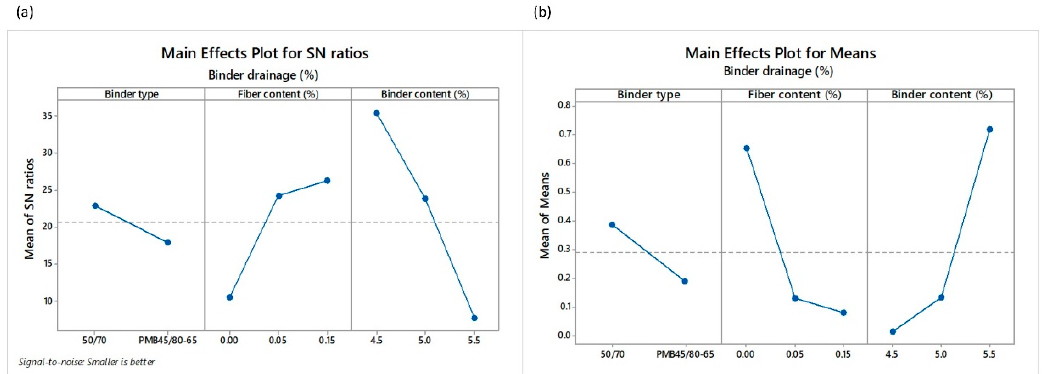
Figure 8. Main effects plots of ( a ) SNR and ( b ) means of the binder drainage ( BD ).